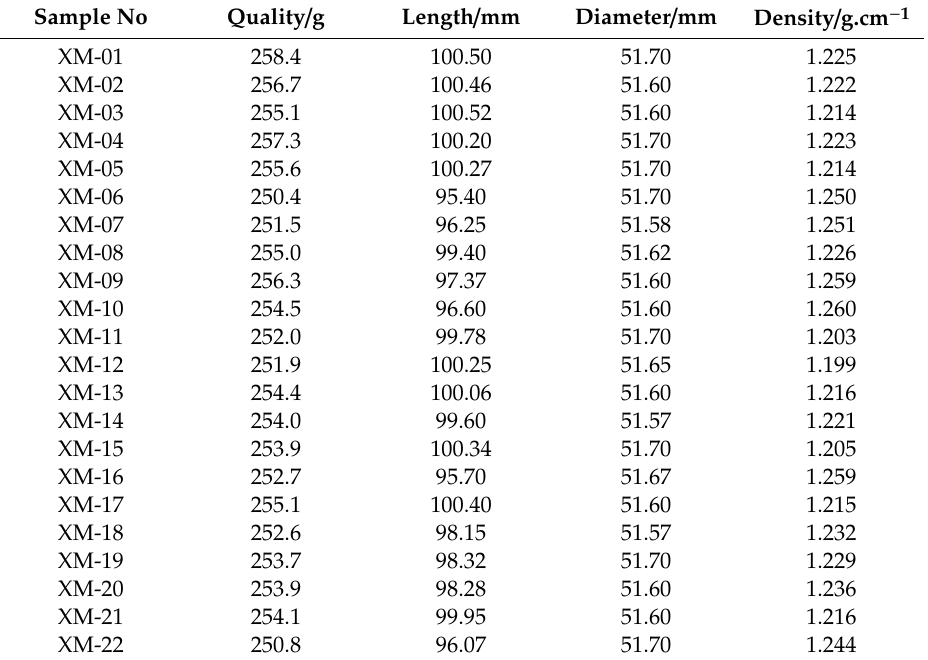
Table 3. Parameters of disc-type briquette